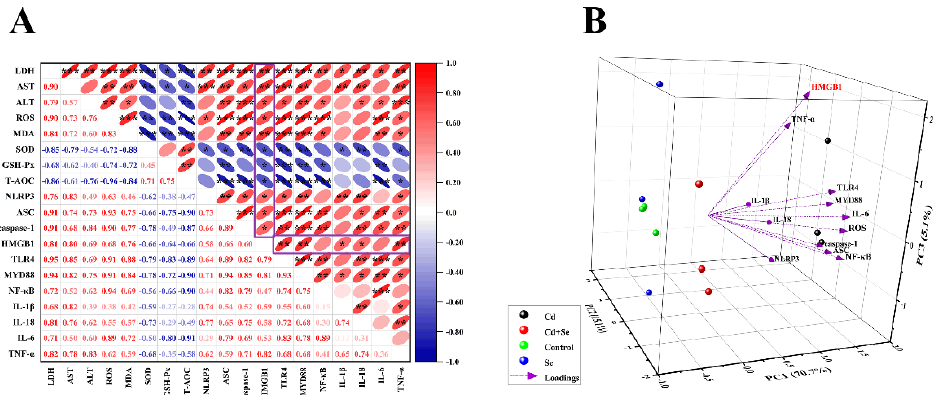
Figure 6 . HMGB1 plays a vital role in Cd-induced hepatocyte damage. ( A ) Correlation analysis between factors related to hepatocyte damage. The color gradient indicates the correlation coefficient, and red is positive correlation, blue is negative correlation. ( B ) Ordination diagram of the principal component analysis (PCA) of HMGB1/TLR4/NF- κ B signaling pathway related factors in hepatocytes induced by Cd or/and Se. The X, Y and Z coordinate axis are three principal components (PC1, PC2 and PC3), respectively, and the percentages in brackets are the percentage of explained variance. “*” indicates a significant correlation (* p < 0.05, ** p < 0.01 and *** p < 0.001).